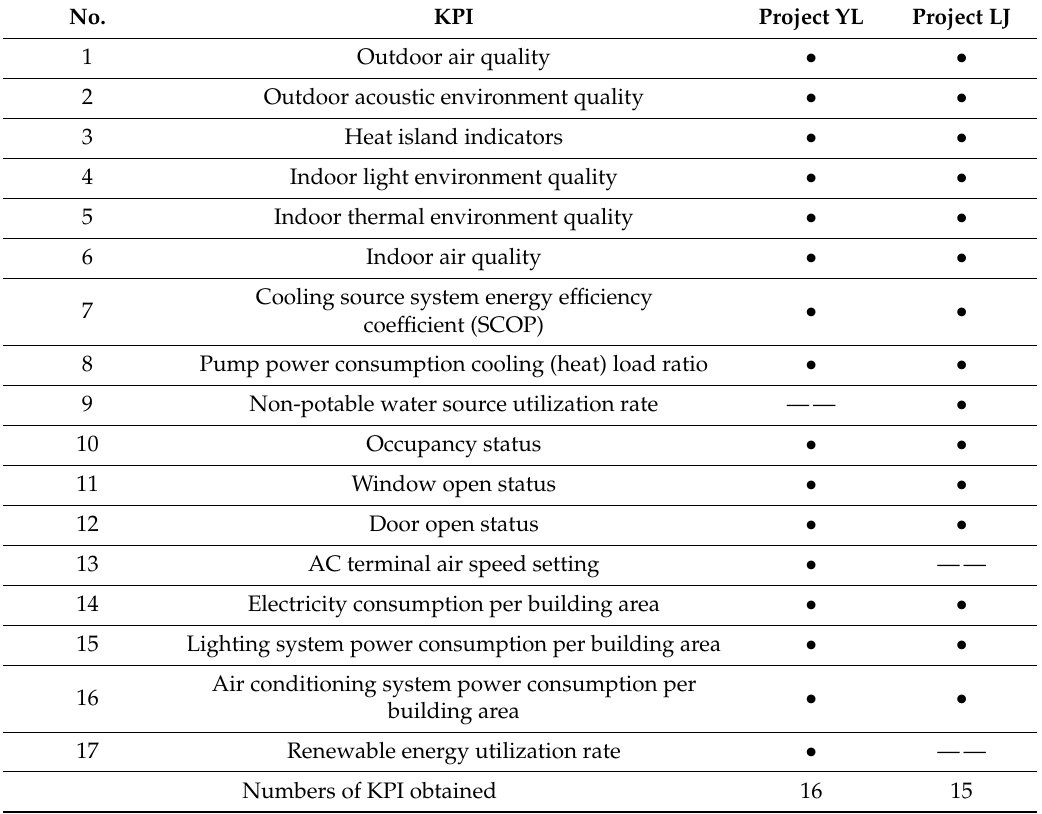
Table 7. The KPI obtained of two projects for case